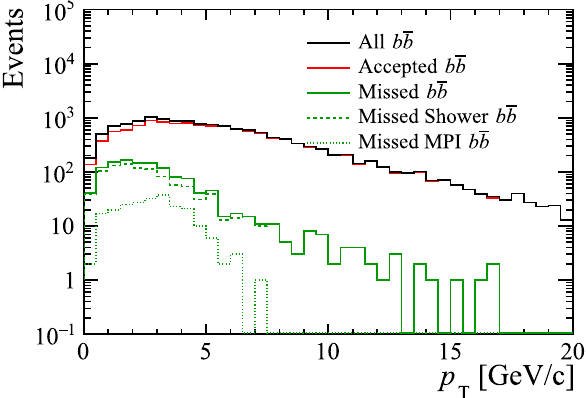
Fig. 7 Kinematic distribution of b -hadrons in Pythia samples gener- ated with the Simple Shower model. Those that are accepted or missed by the UserHooks discussed in the text with a ˆ p T scale of 4GeV are highlighted and further split according to whether the missed heavy quarks originated during the parton shower or as an additional MPI process